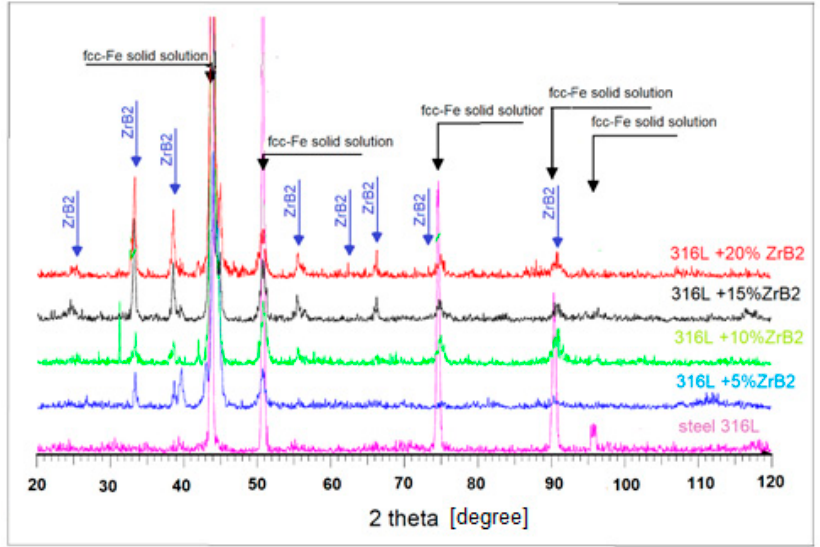
Figure 3. Diffraction pattern of sintered materials obtained by SPS at 1373 K under 35 MPa and during 5 min.